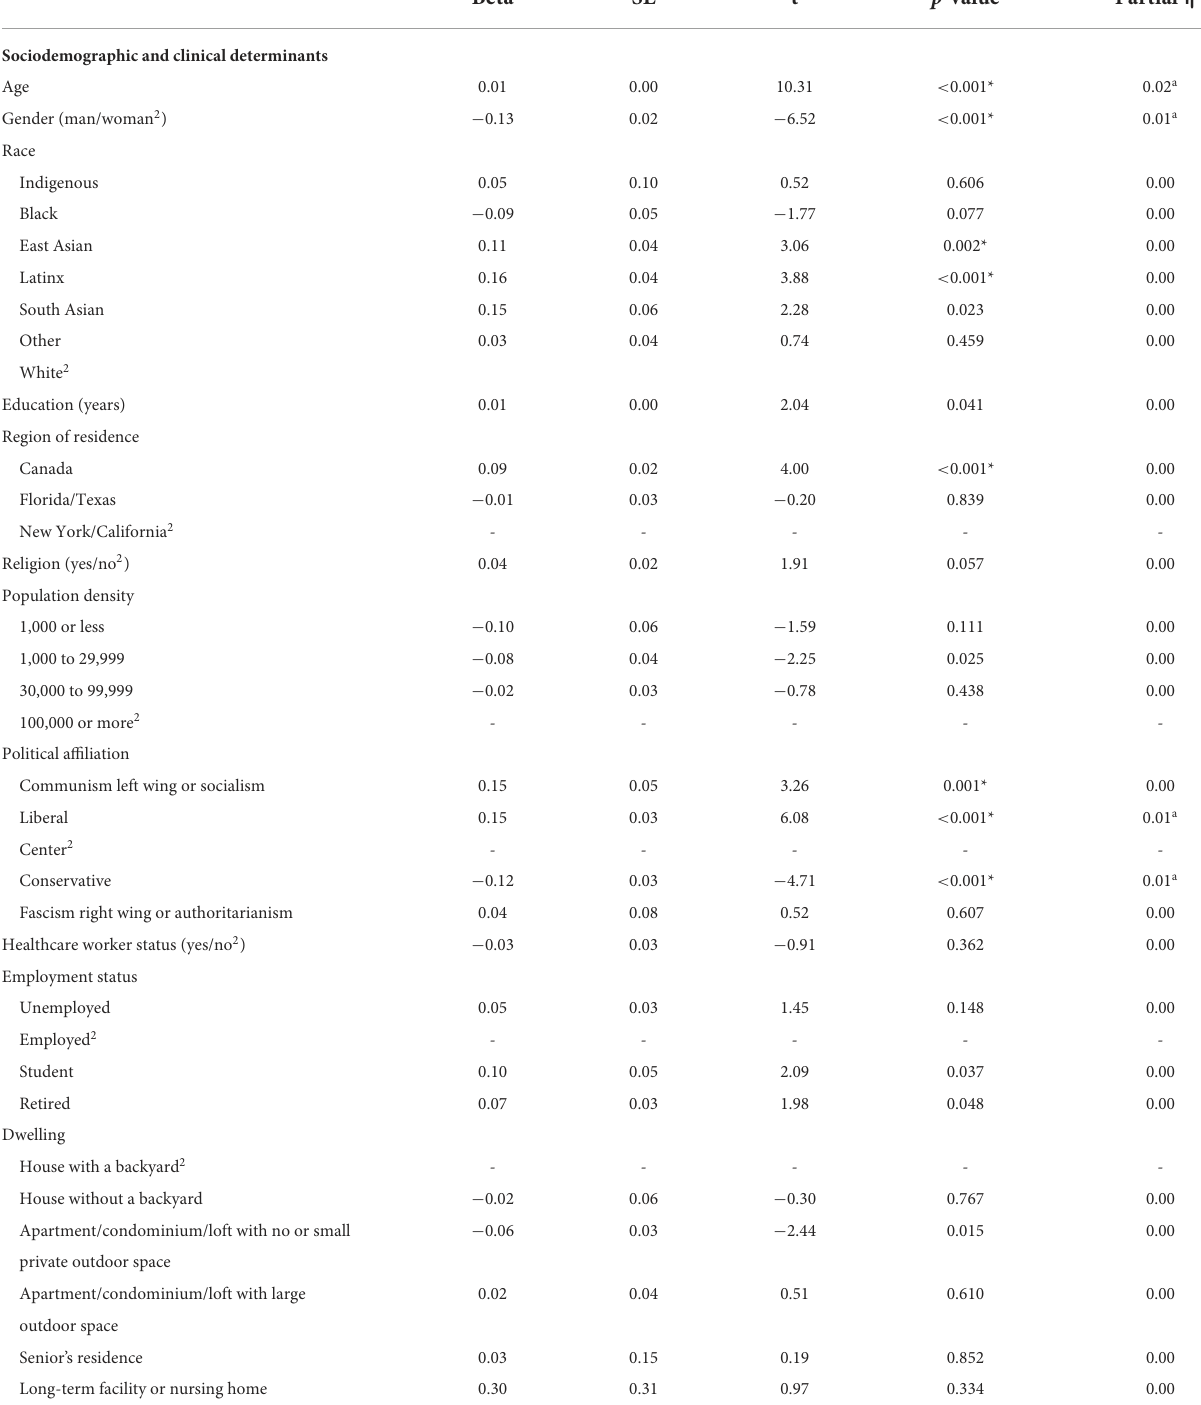
TABLE 2 Univariate analysis examining the association between sociodemographic, COVID-19 and social distancing related, and psychological determinants and social distancing adherence. 1 Beta SE t p -value Partial η